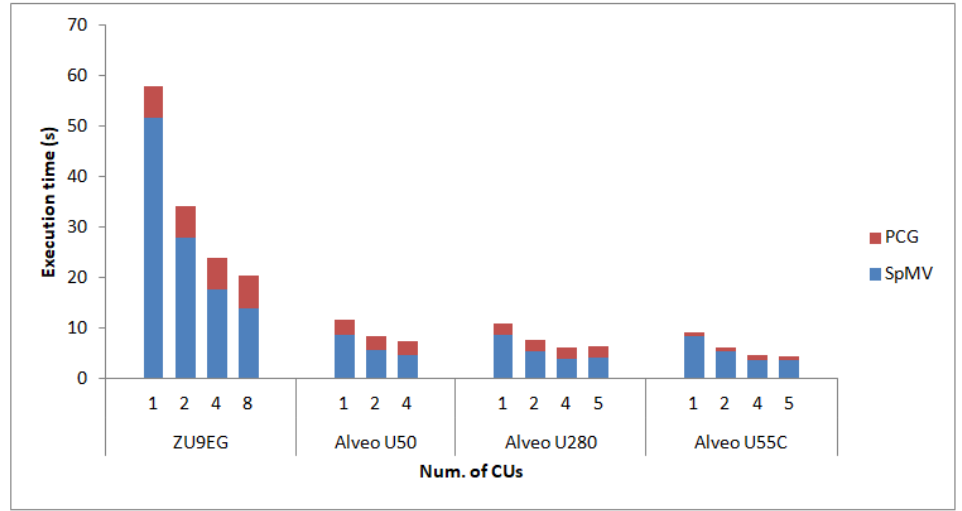
Figure 2. Test case Cube_35199—execution time of 100 iterations of PCG on different hardware varying the number of CUs. The time of the PCG and the corresponding SpMV products are highlighted in red and blue, respectively.